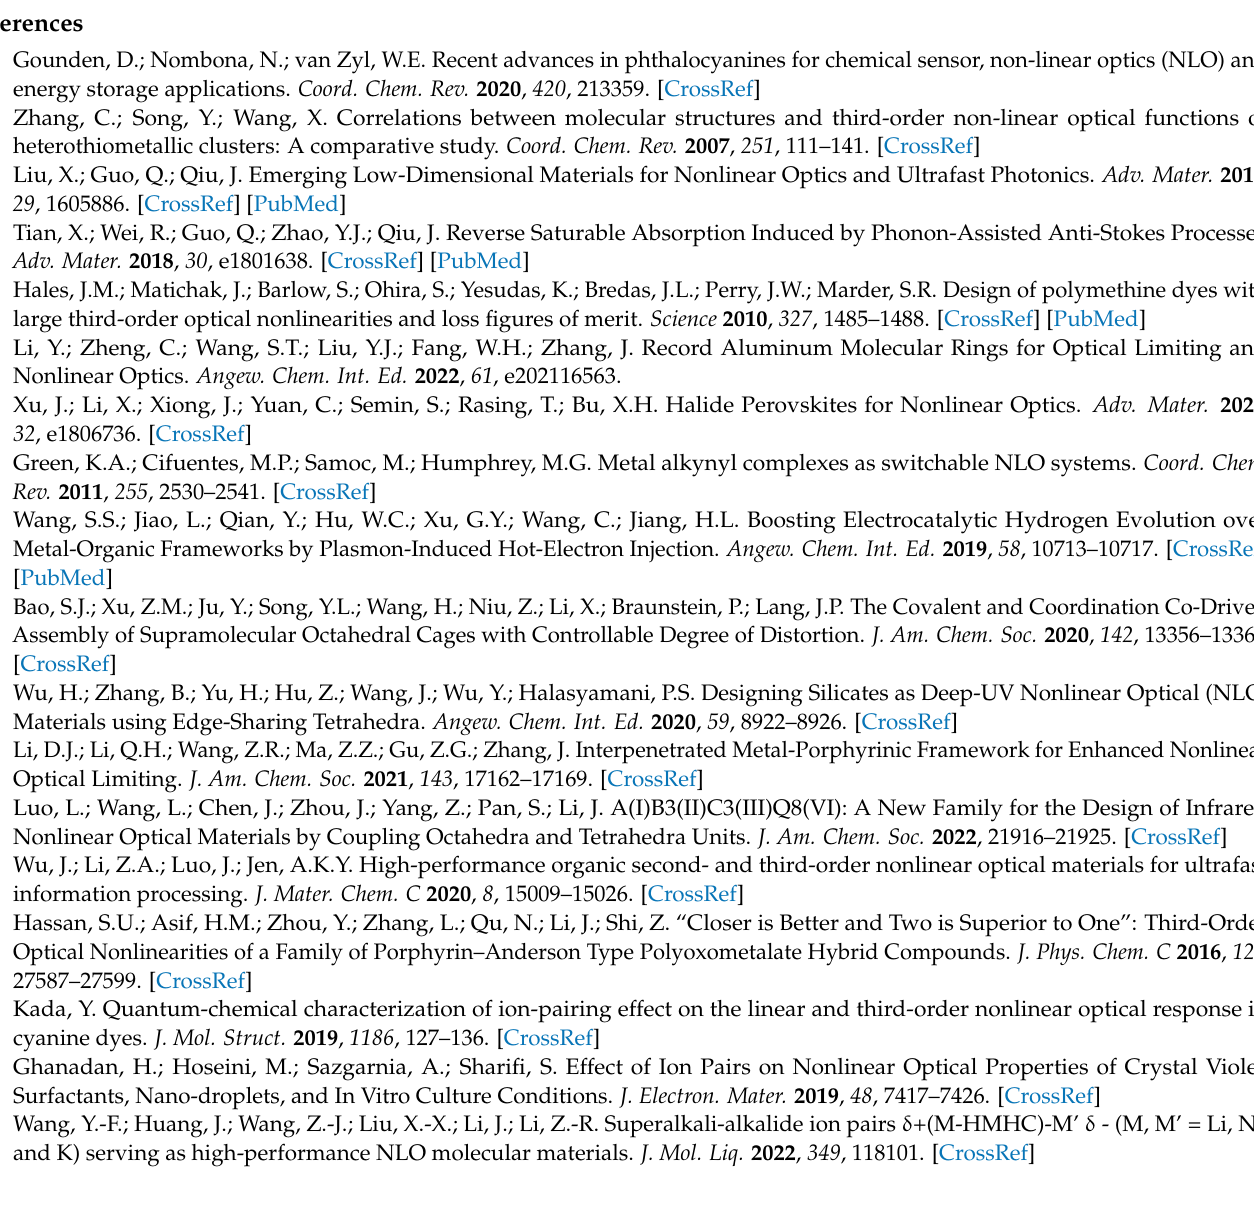
Calculations; Table S1. Linear and NLO data of PDMS-PTCs